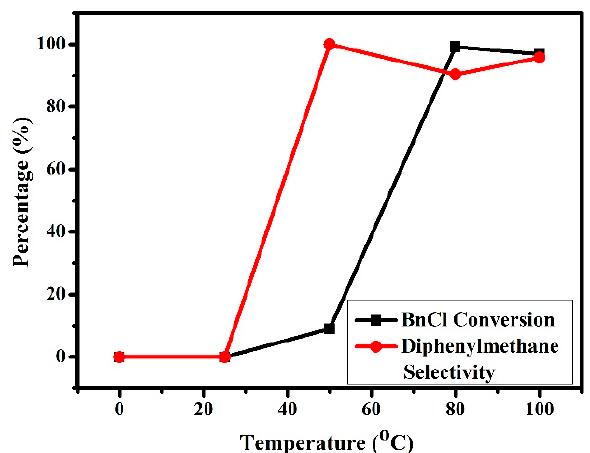
Figure 3. The effects of reaction temperature on the Friedel–Crafts alkylation reaction of p-xylene with BnCl (under a 5c catalyst dosage of 1.0 mole %, a reaction time = 0.5 h, and a molar ratio of p-xylene: BnCl = 2:1).